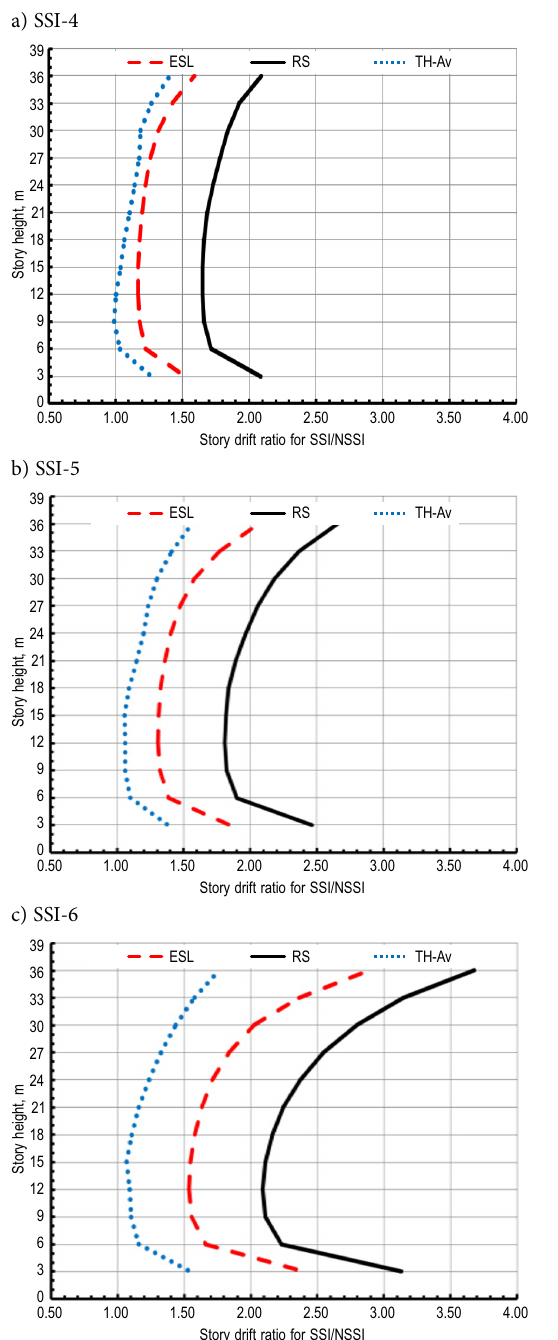
Fig. 7. Story drift ratio of SSI model to that of NSSI model of 12-story models